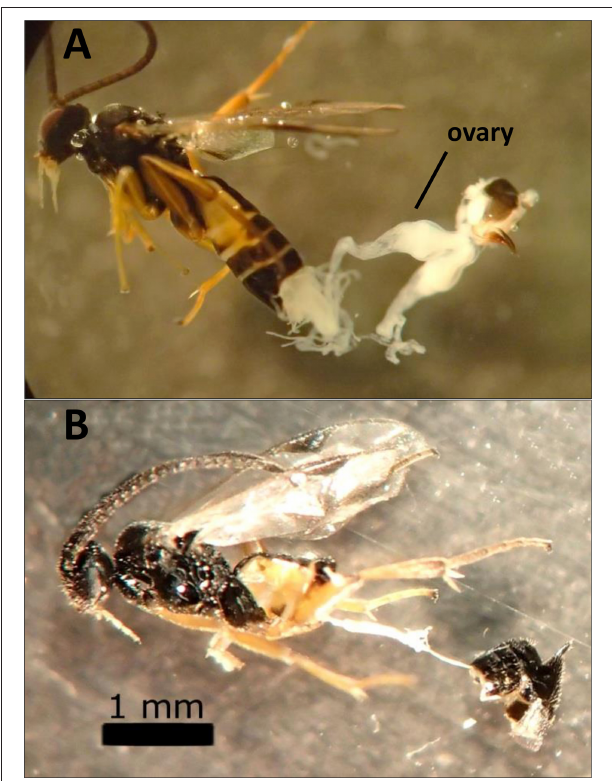
FIGURE 3 | Images of dissected hybrid females produced from crosses between two incipient species of Cotesia congregata (MsT = Manduca sexta on tobacco and CcC = Ceratomia catalpae on catalpa). (A) MsT ♂ xCcC ♀ hybrid female with normal ovaries. (B) Sterile CcC ♂ xMsT ♀ hybrid female that lacks developed ovaries (alimentary tract